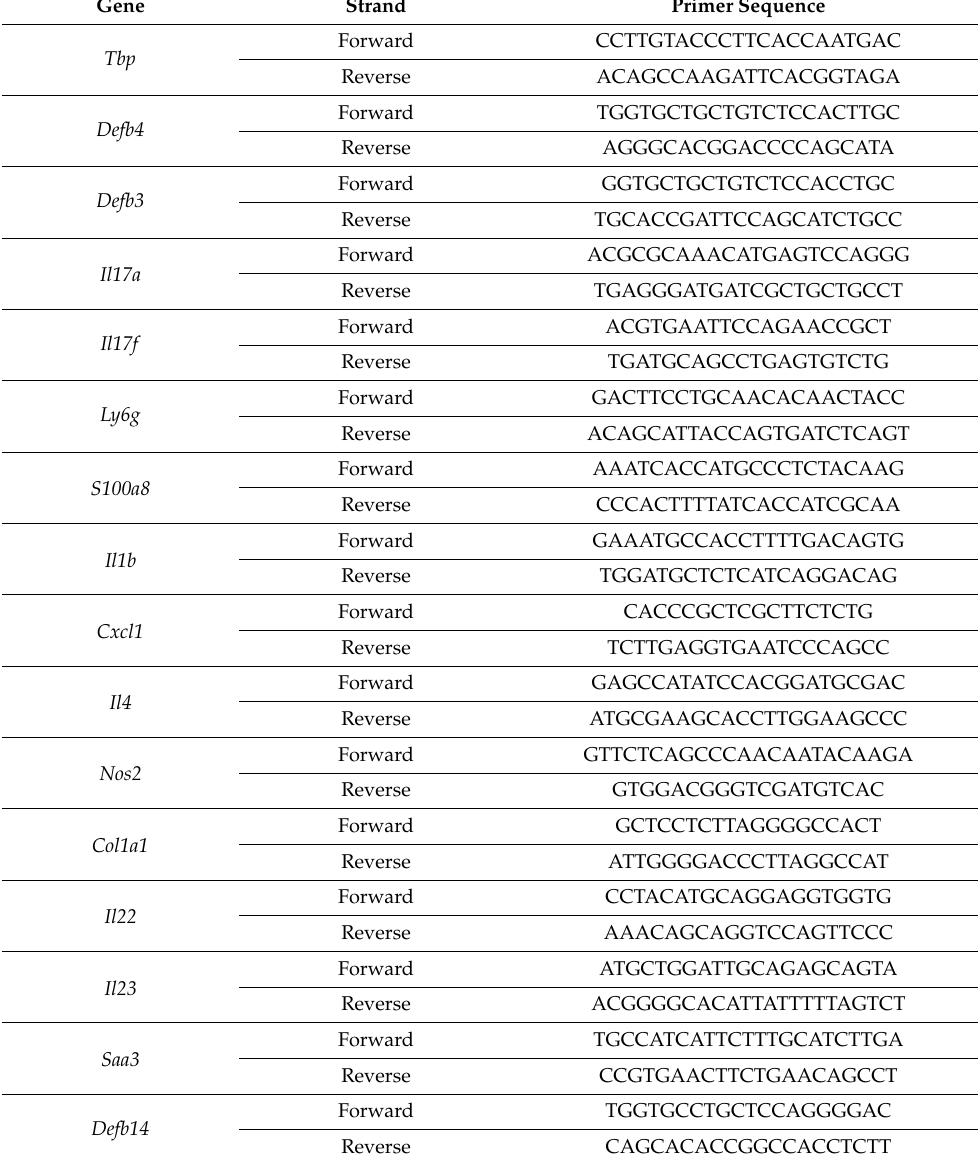
Table 2. List of primers used for qRT-PCR